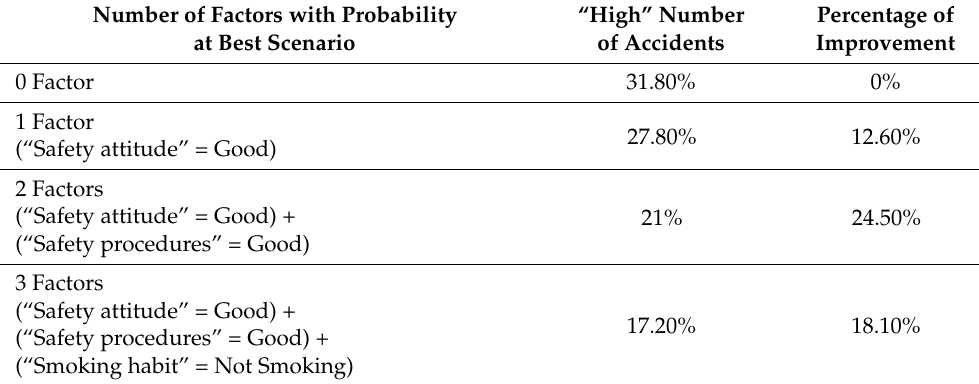
Figure 5. Sensitivity analysis results of single and joint-factor strategies, from two to nine factors.